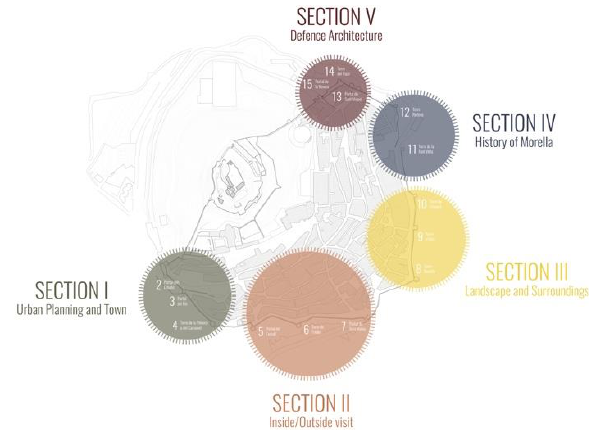
Figure 6. Thematic sections of the “Walls Walking Tour” (Source: S. Portela, 2018).